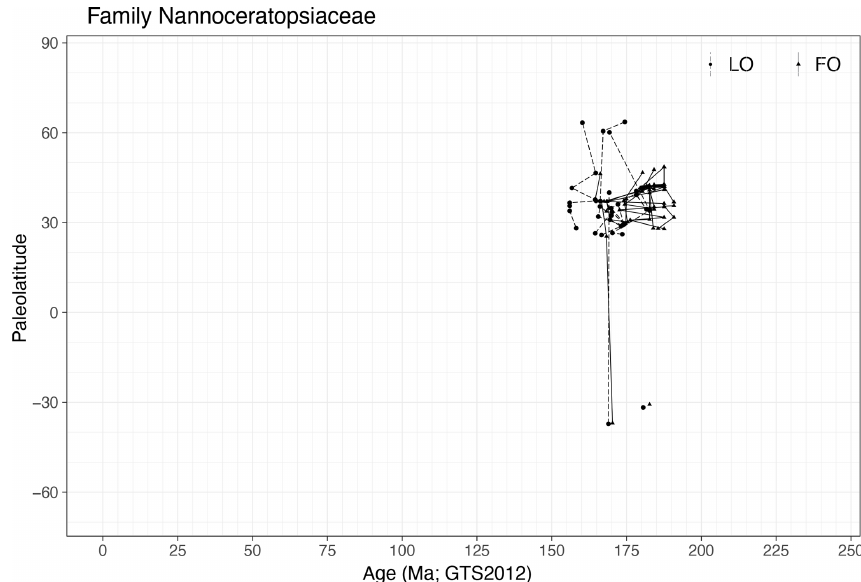
Figure 26. Same as Fig. 5 but for the family Nannoceratopsiaceae.